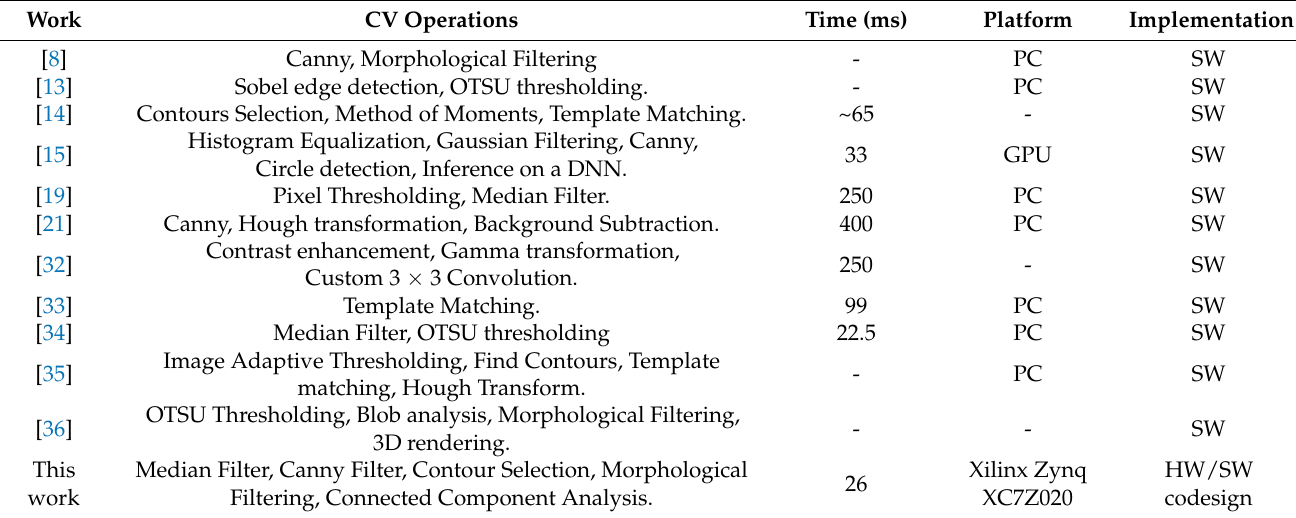
Table 3. Comparison with prior